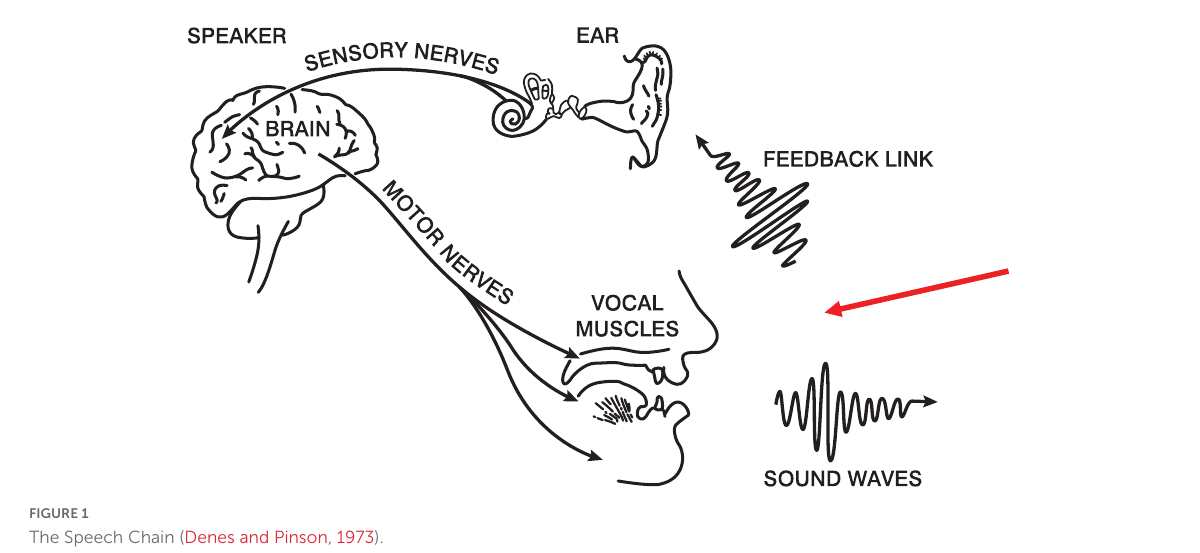
FIGURE1 The Speech Chain (Denes and Pinson,